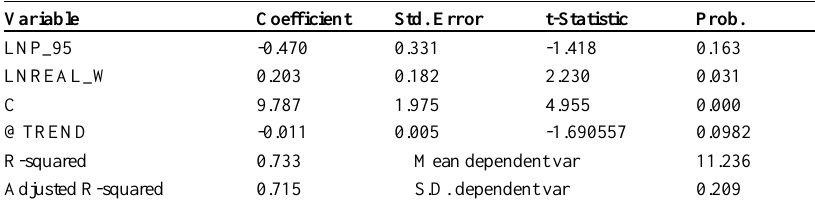
Table 11. Criteria for statistical significance for long-term dependence in the post-